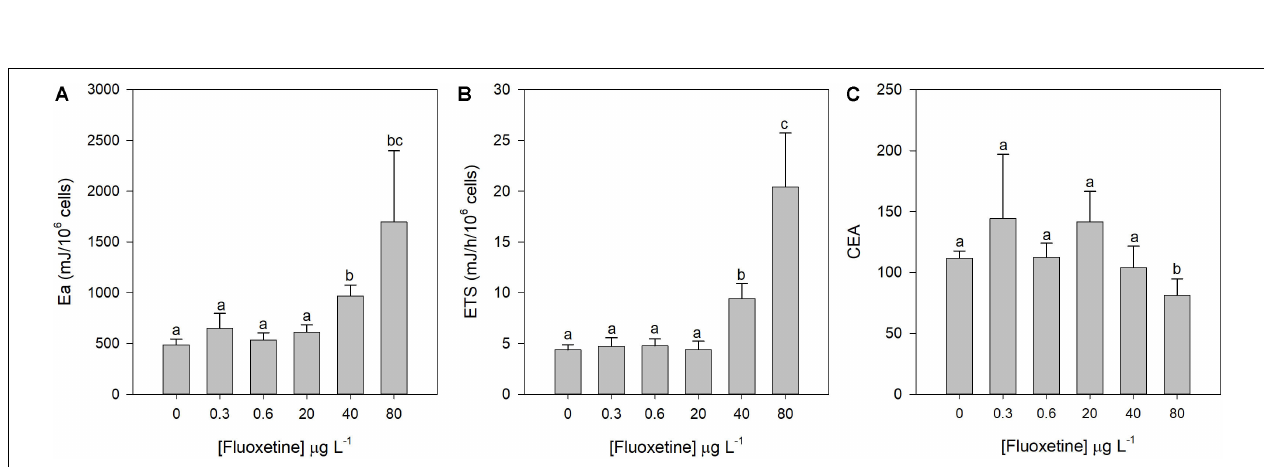
Frontiers in Microbiology |